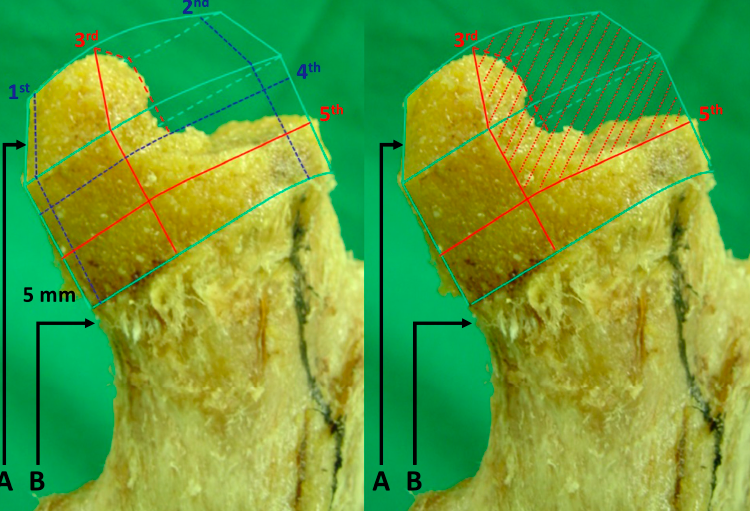
Figure 2. Anatomic specimens of the femur obtained from ten cadavers. Note: A: Femoral head, B: Femoral neck. We drew the 1st and 2nd lines along the midline of the femoral neck on the anterior–posterior and lateral plane, respectively. Then, we drew the 3rd line that crosses the 1st and 2nd lines from postero-superior to infero-anterior directions. We also drew the 4th line, that was vertical to the 3rd line and then crossed the center of the femoral head. In parallel with the 4th line, we drew the 5th line at 5 mm proximal to the head–neck junction. Finally, we dissected 50% of the antero-superior part of the remaining femoral head based on the 3rd and 5th lines.